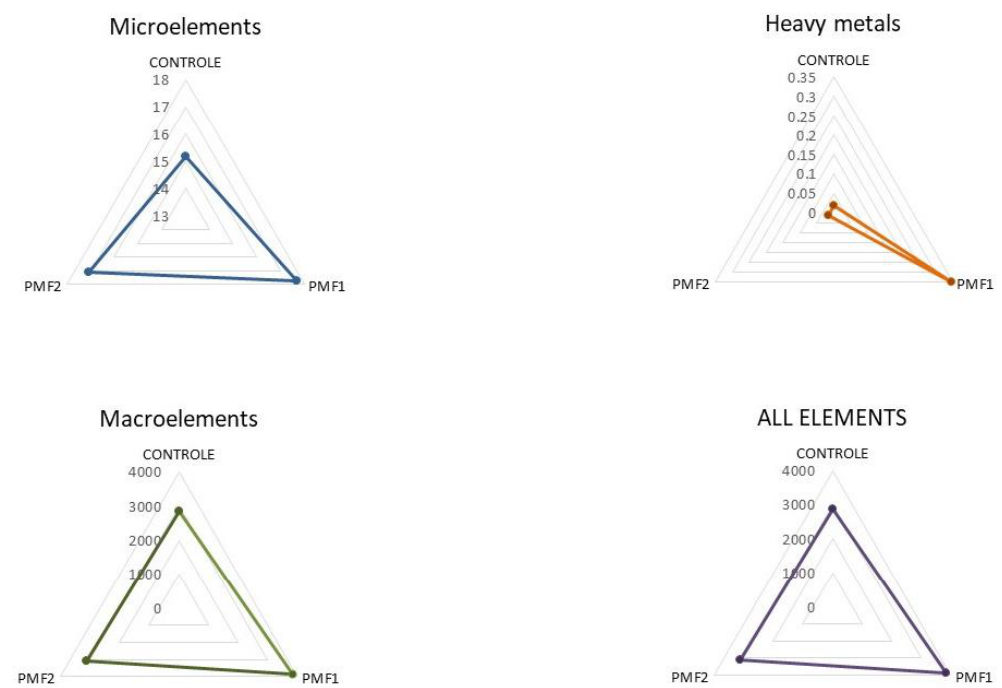
Figure 8. Changes in micro – macro elements and heavy metals and the sum thereof under the influence of the application of doses of the pulsating magnetic field for sunflower sprouts.